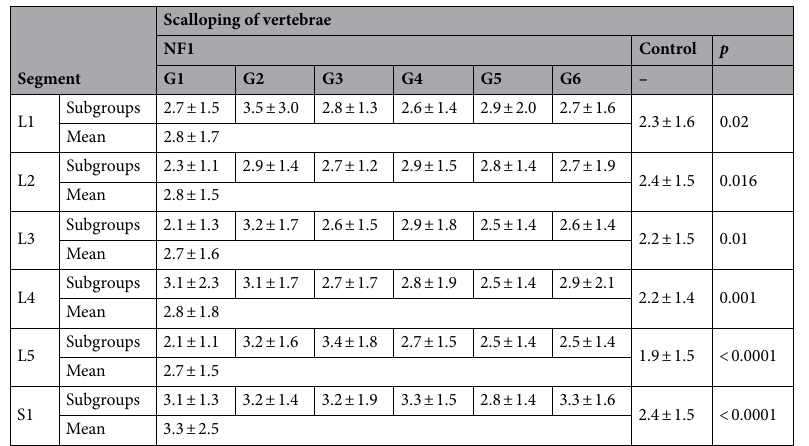
Table 3. Measurement of vertebral scalloping in NF1 patients and the control group. Values represent mean values ± standard deviation. Values are given in mm. G1: genetic subgroup 1 (type-1 deletion); G2: genetic subgroup 2 (splice mutation); G3: genetic subgroup 3 (missense); G4: genetic subgroup 4 (nonsense/frameshift mutation); G5: genetic subgroup 5 (no proof of mutation); G6: genetic subgroup 6 (no analysis